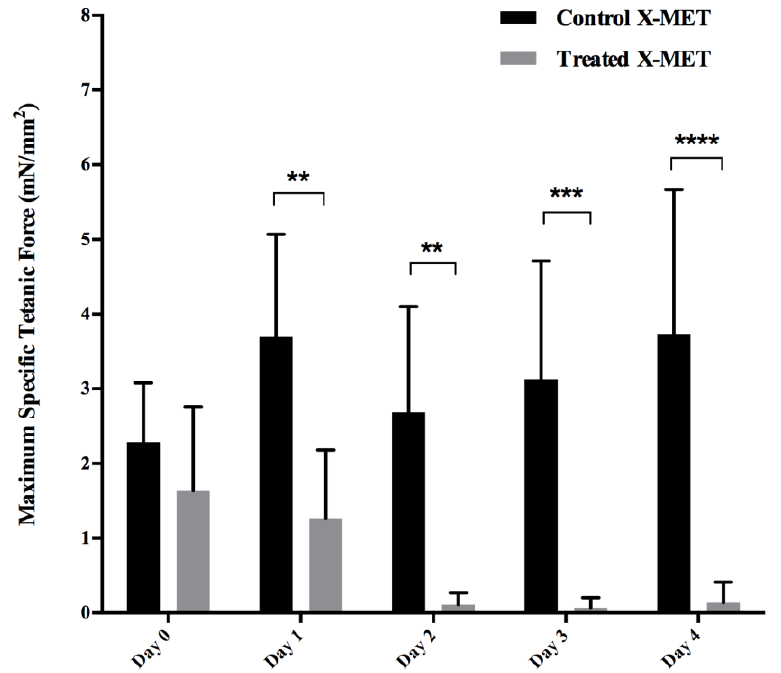
Figure 10. Maximum specific tetanic force in control and treated X-METs for the five days of acquisition. ** p -value < 0.01. *** p -value < 0.001. **** p -value < 0.0001 (from two-way ANOVA).